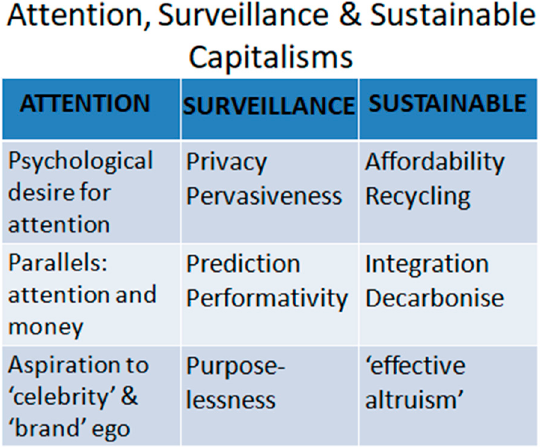
Figure 2. The three featured models of contrarian spatial development planning.